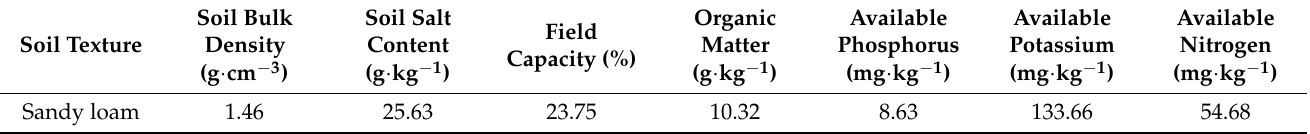
Table 9. Physical and chemical properties of the